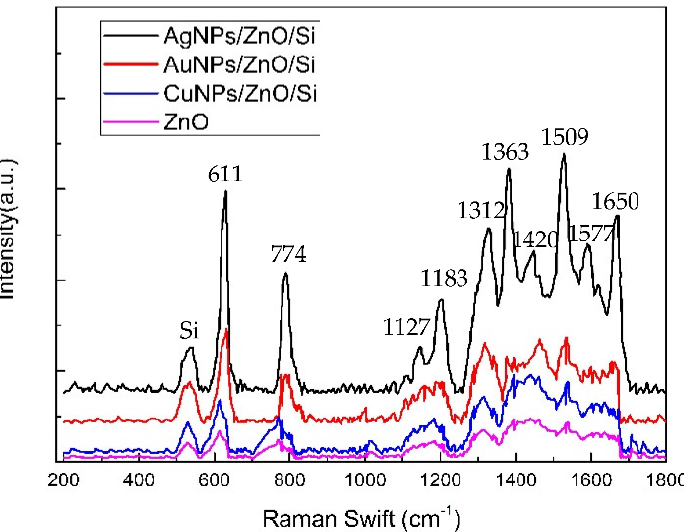
Figure 3. Raman spectra of simple ZnO, AgNPs/ZnO/Si, AuNPs/ZnO/Si, and CuNPs/ZnO/Si structures.